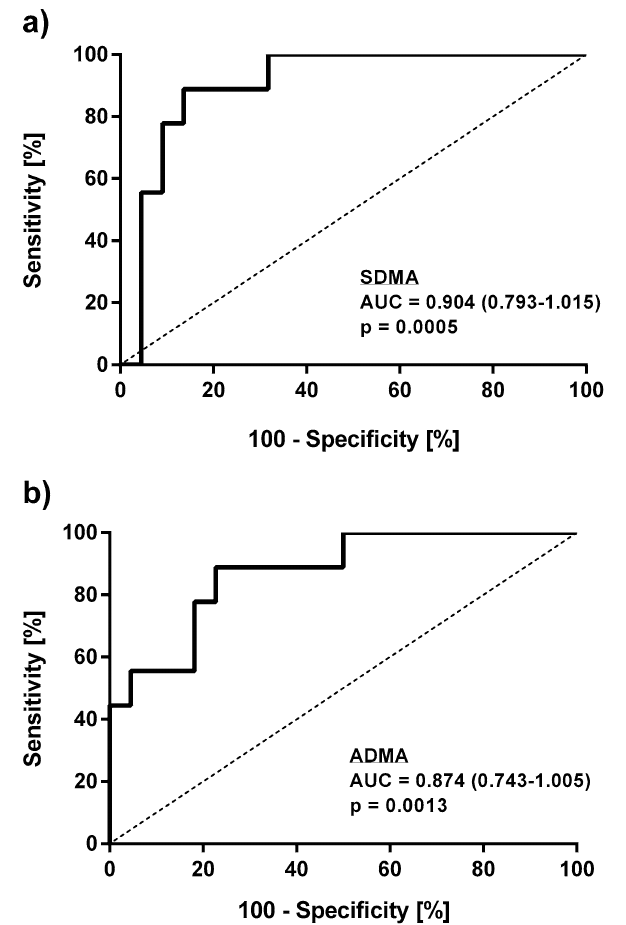
Figure 3. Receiver-operated curve (ROC) analyses of ADMA ( a ) and SDMA ( b ) for in-hospital mortality. AUC, area under the curve.